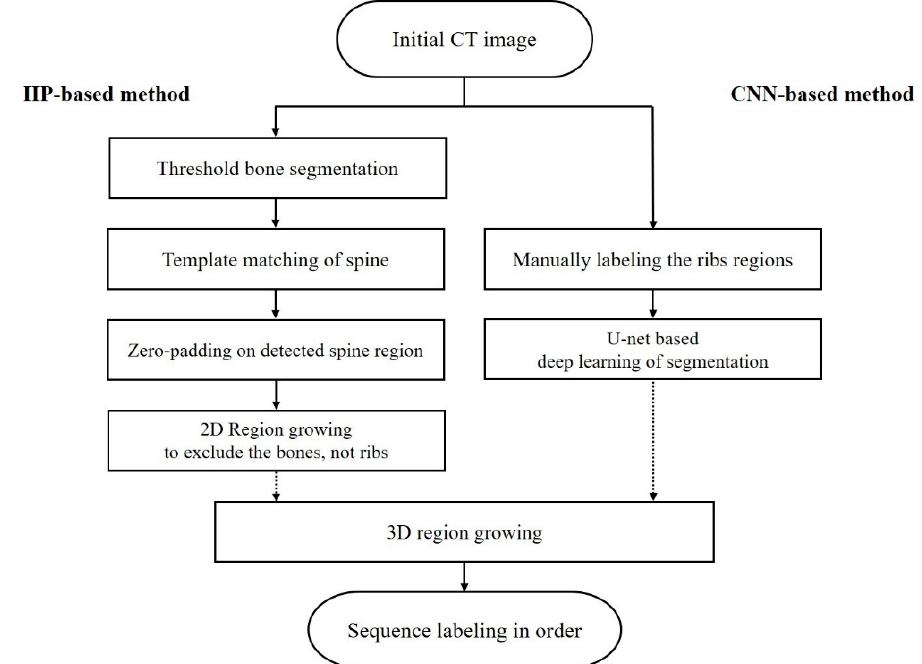
Figure 1. Flowchart of rib sequence labeling processes using IIP-based method and CNN-based method; (IIP—intensity-based image processing; CNN—convolutional neural network).